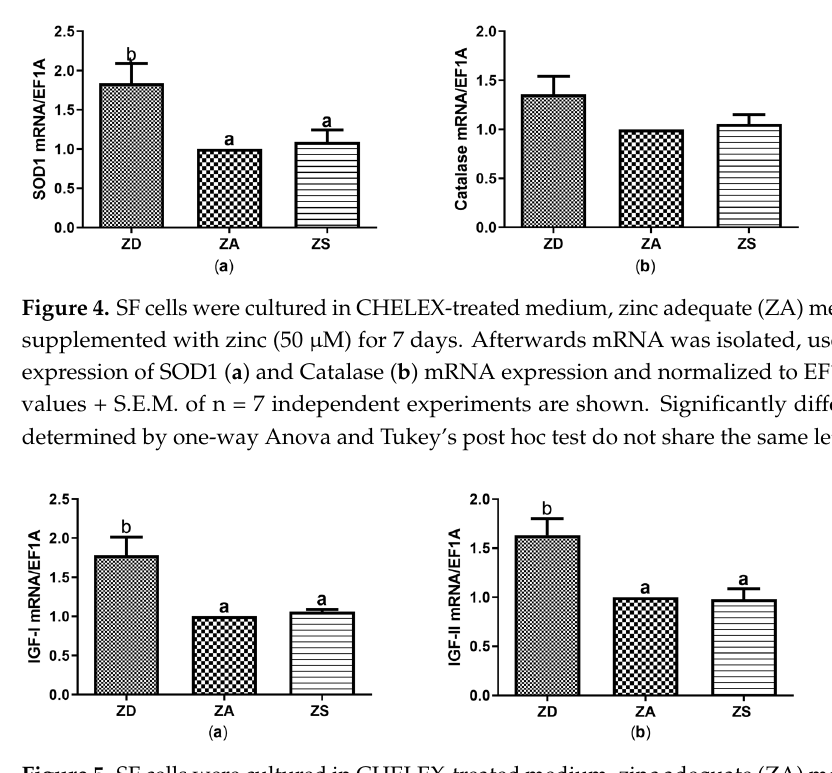
Figure 5. SF cells were cultured in CHELEX-treated medium, zinc adequate (ZA) medium or medium supplemented with zinc (50 µ M) for 7 days. Afterwards mRNA was isolated, used for measuring expression of IGF-I ( a ) and IGF-II ( b ) mRNA expression and normalized to EF1A mRNA. Mean values + S.E.M. of n = 7 independent experiments are shown. Significantly different data sets as determined by one-way Anova and Tukey’s post hoc test do not share the same letters ( p < 0.05).